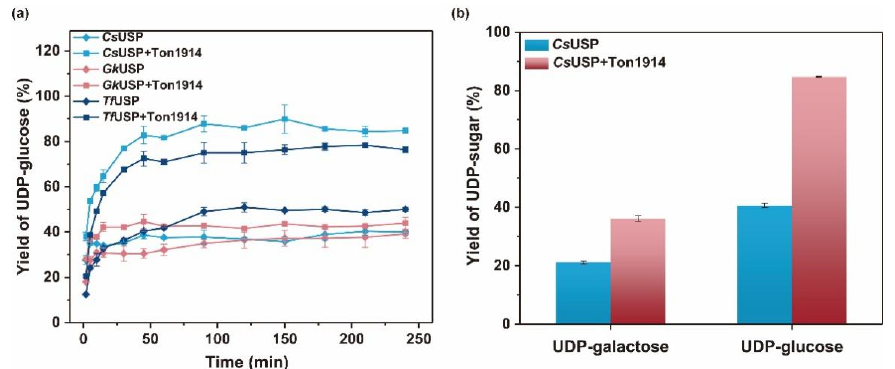
Figure 5. Improvement in Ton1914 for UDP-sugar synthesis. ( a ) The effect of Ton1914 on the yield of UDP-glucose catalyzed by different UDP-glucose pyrophosphorylases ( Cs USP, Gk USP, Tf USP); ( b ) The yields of UDP-glucose and UDP-galactose catalyzed by Cs USP and Ton1914. ( b ) The yields of UDP-glucose and UDP-galactose catalyzed by Cs USP and